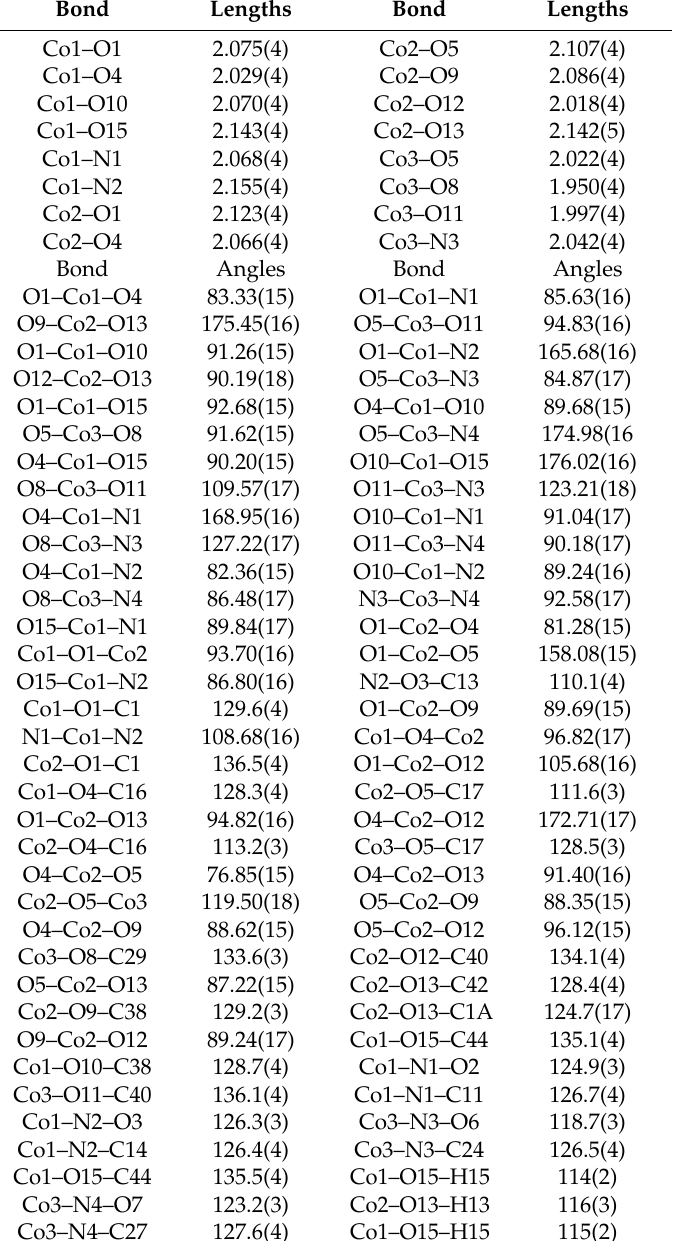
Table 2. Selected bond lengths (Å) and angles ( ◦ ) of the Co(II)